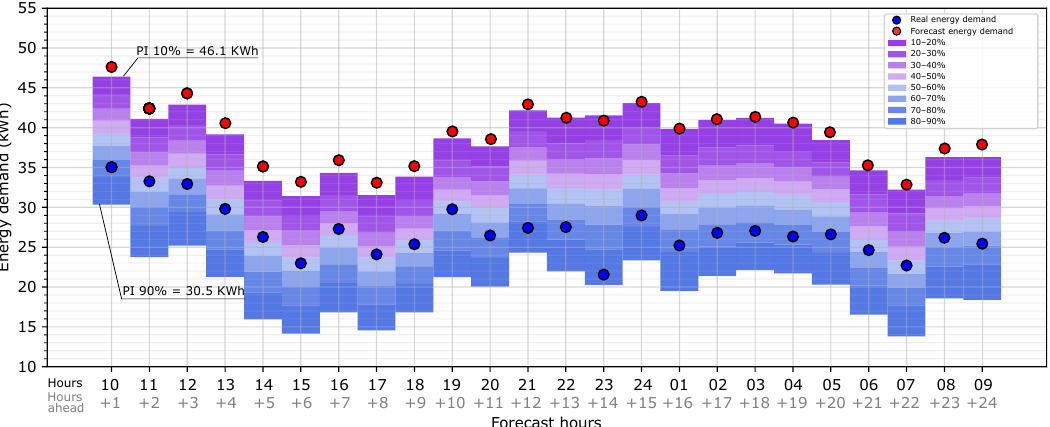
Figure 10. Application of the map of the heating load forecast uncertainty due to forecast weather data using the whole period of the study for a random day: 2 January